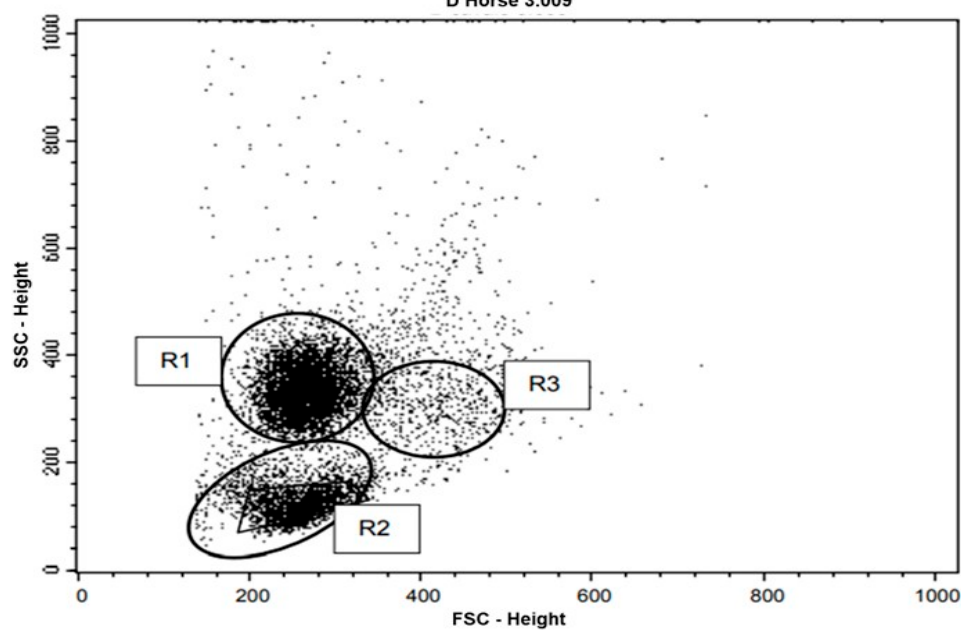
Figure 1. Representation of peripheral blood leukocyte flow cytometry data of the studied horses, after lysis of erythrocytes, in a dot plot. Cell populations were selected according to their forward scatter (FSC) versus side scatter (SSC) profiles indicating cell size versus granularity and complexity. R1 corresponds to the neutrophil gate, R2 corresponds to lymphocytes, and R3 corresponds to monocytes.